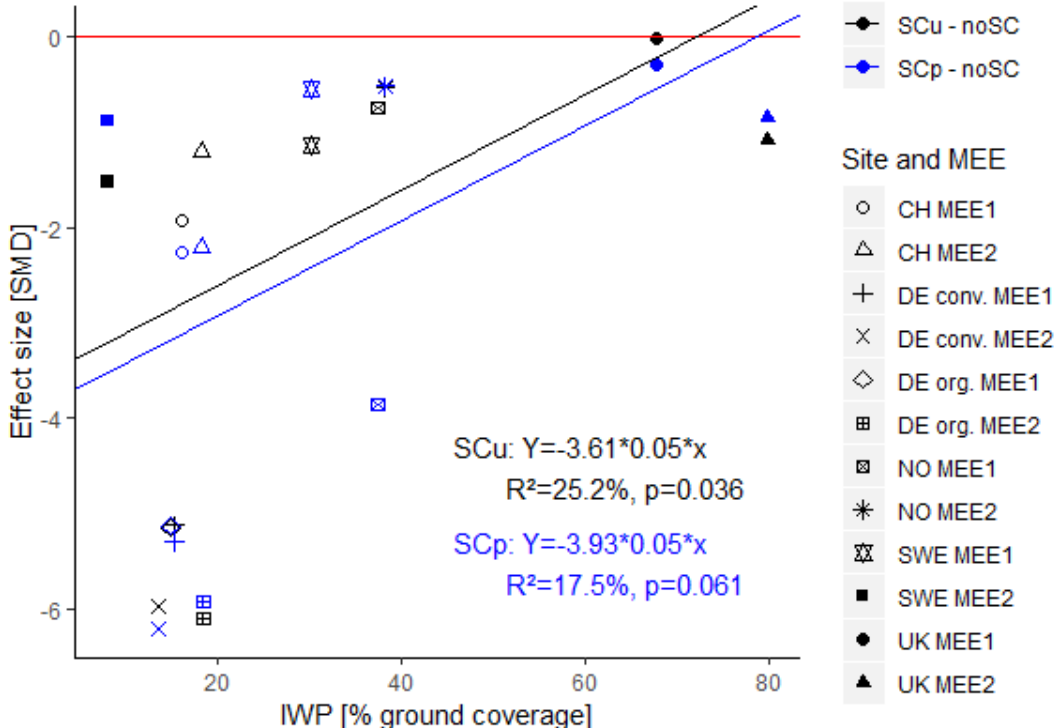
Figure 3. The relation between inherent weed pressure (IWP) and the e ff ect of under-sown (SCu, black) and post-harvest sown subsidiary crops (SCp, blue) on the weed coverage. The values for the e ff ect sizes are given in standardized mean di ff erence (SMD). A negative SMD represents a lower weed coverage associated with the SCu or SCp treatments, and vice versa. Inherent weed pressure is calculated as average ground coverage over all treatments and is given in % ground coverage. Site and MEE are represented by di ff erent symbols. (MEE1 / MEE2—first / second round of the multi-environmental experiments).